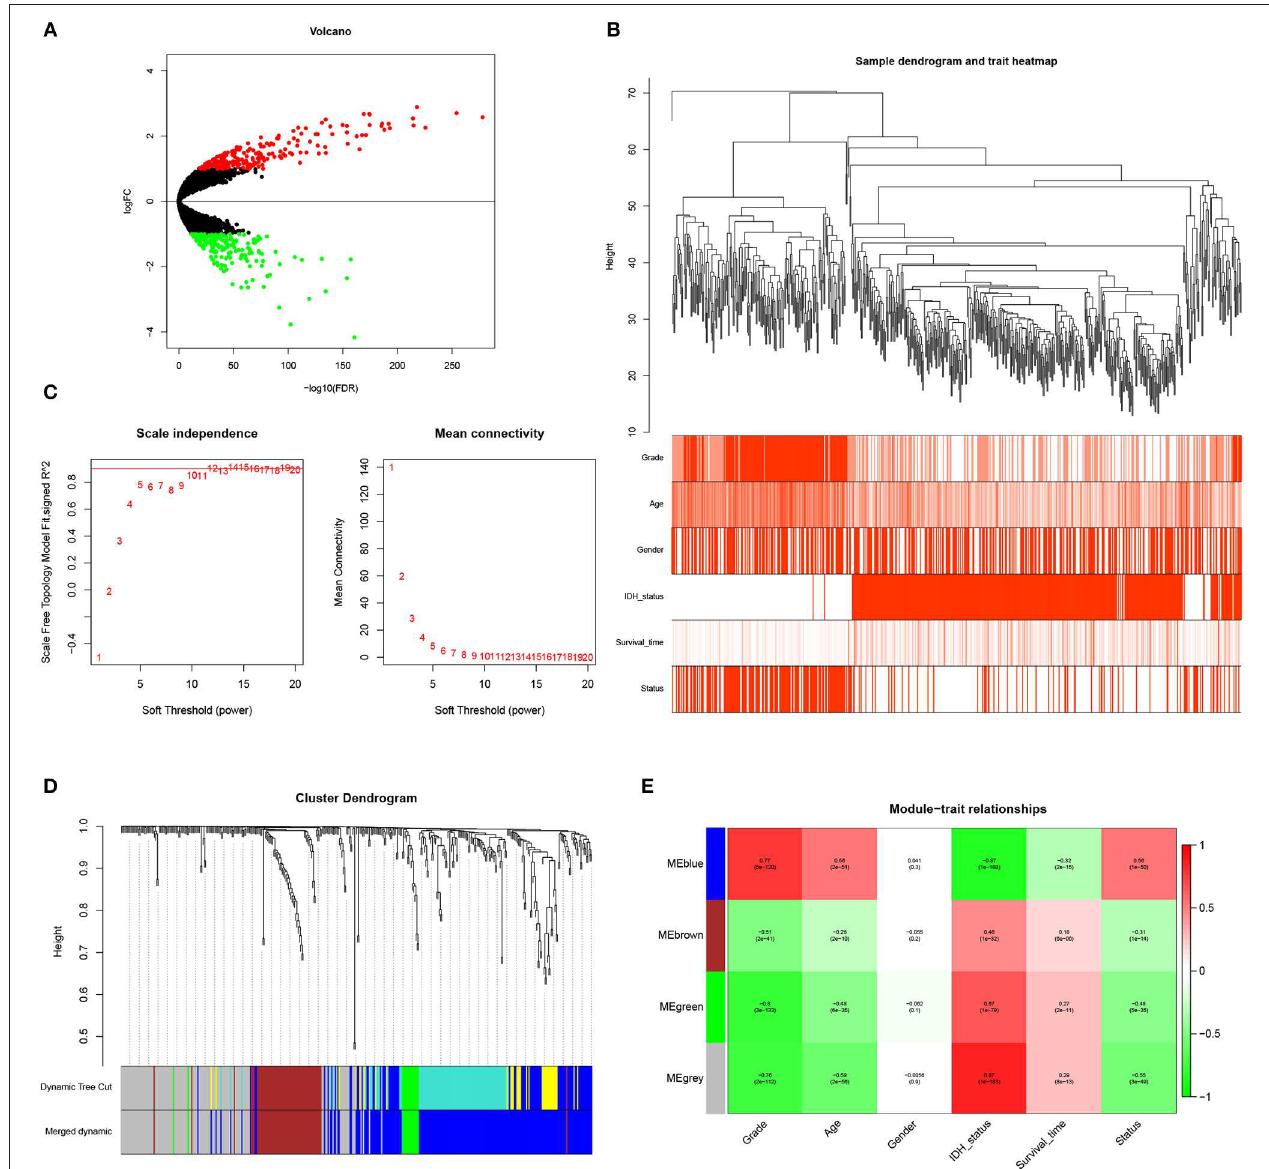
FIGURE 1 | Identification of WHO grade-related genes in glioma. (A) Volcano plot showed the distribution of DEGs. (B) Sample clusters showed basic clinical information of glioma patients. (C) The soft threshold power was calculated and 10 was selected as the power value. (D) Similar modules were merged and four modules were generated. (E) Heatmap exhibited the relationships between gene modules and clinical traits by Pearson correlation.